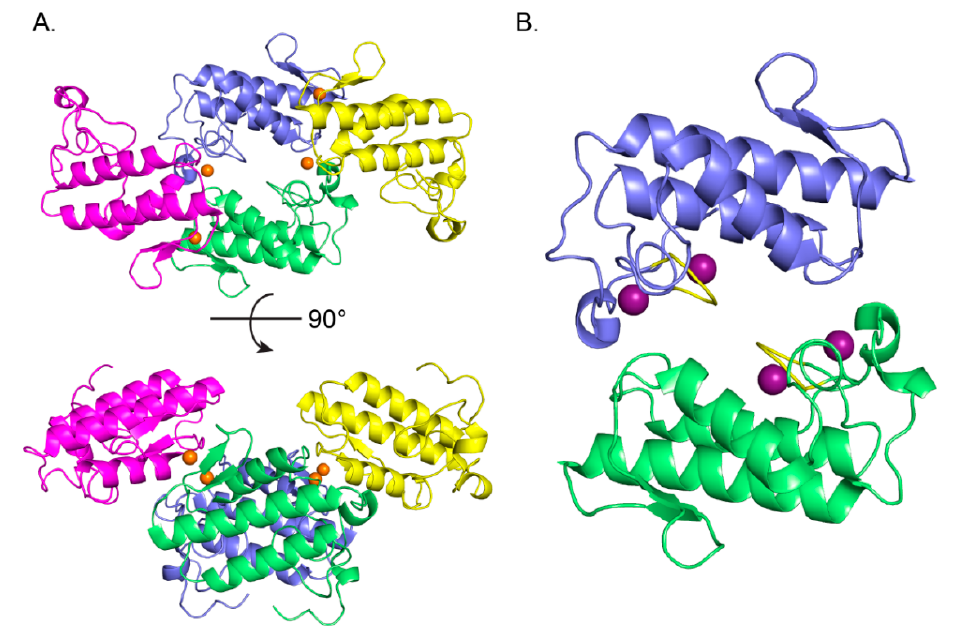
Figure 3. Oligomeric assembly of the CBd isoform. ( A ) Tetrameric quaternary organization of CBd (polypeptide chains A in green, E in blue, B in magenta, C in yellow). Chloride ions are shown as orange spheres. ( B ) Structure of the central CBd-CBd dimer (polypeptide chains A,E). Two Na + binding sites in each monomer are shown as purple spheres and the canonical calcium-binding loop is shown in yellow.